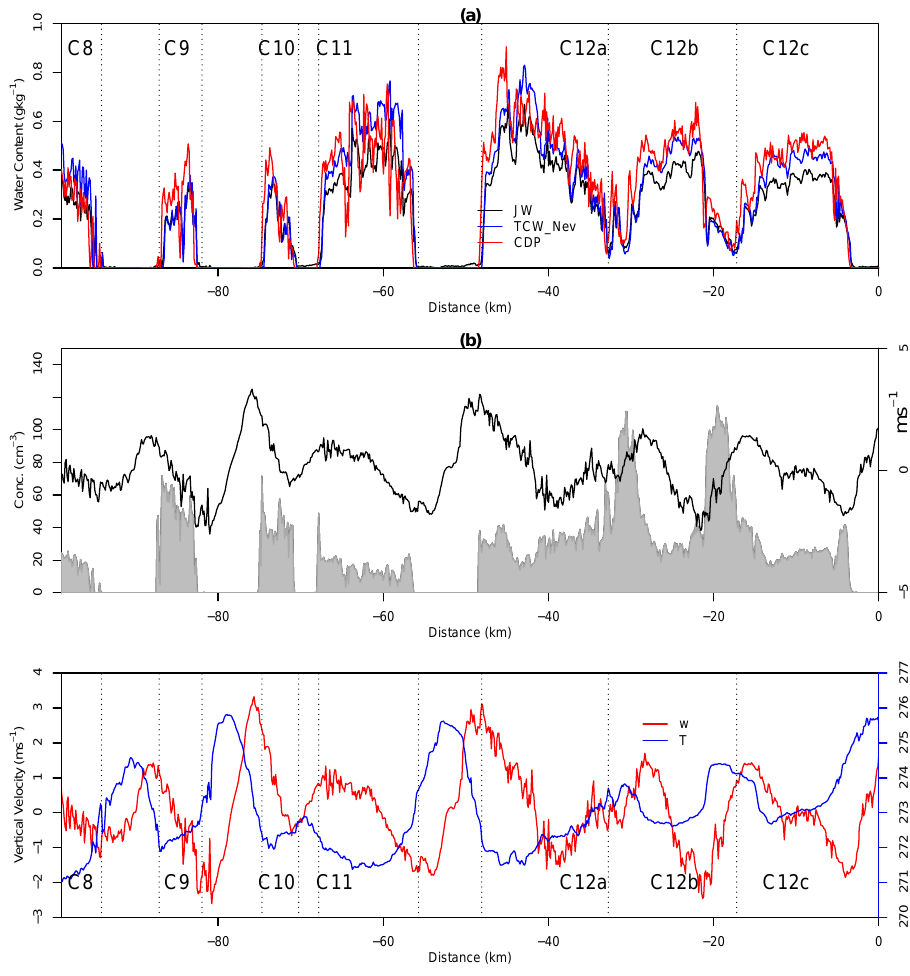
Fig. 7. As in Fig. 4 but for Run